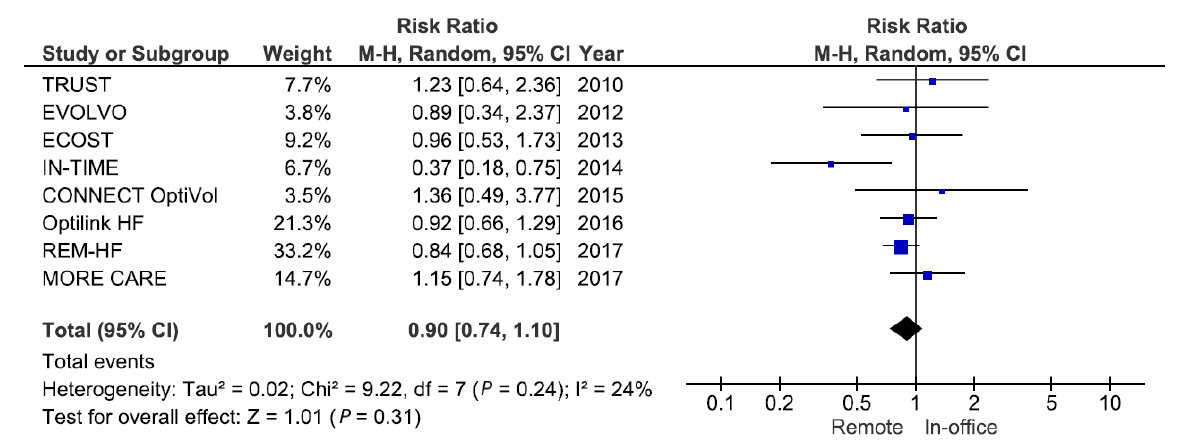
Figure 5. Pooled relative risk for randomized clinical trials examining the effect of remote monitoring on all-cause mortality among patients with an implantable cardioverter-defibrillator or cardiac resynchronization defibrillator. Abbreviations: 95% CI = 95% confidence intervals; M-H = Mantel–Haenszel test.